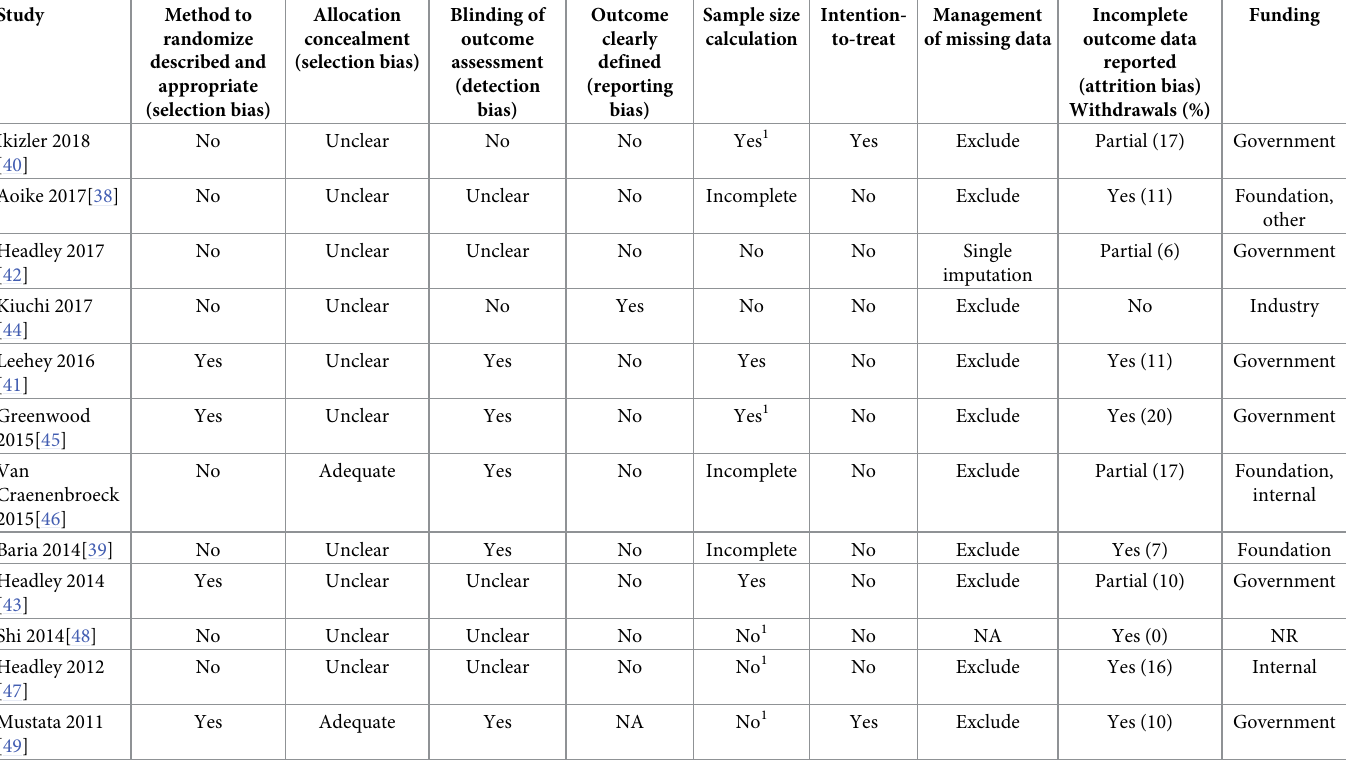
Table 3. Risk of bias